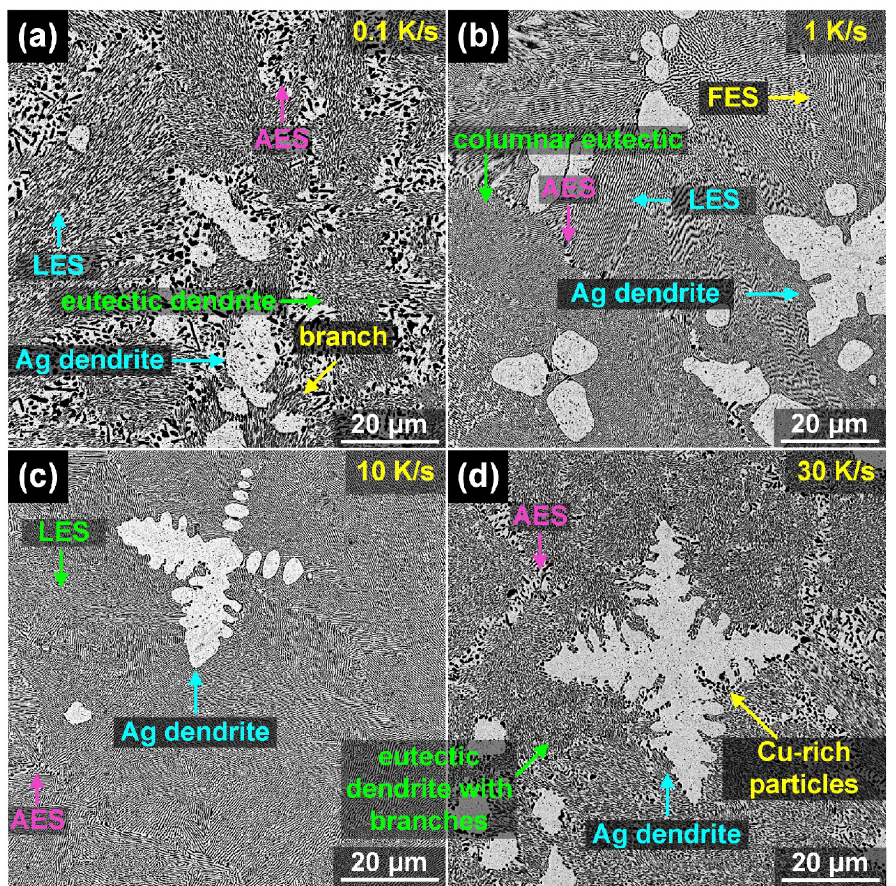
Figure 1. Solidified microstructures in Ag-Cu eutectic alloys under different cooling rates: ( a ) 0.1 K/s, ( b ) 1 K/s, ( c ) 10 K/s and ( d ) 30 K/s.